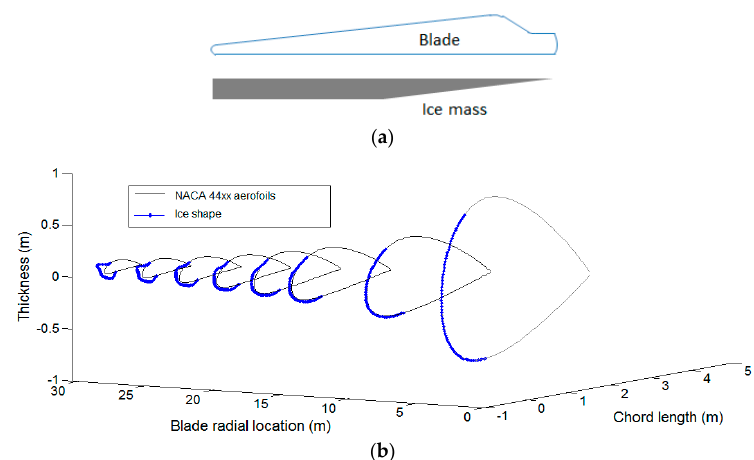
Figure 5. ( a ) Germanischer Lloyd (GL) ice mass distribution; and ( b ) 100% GL ice mass distribution on the Tjaereborg turbine blade with Ice shape 2.